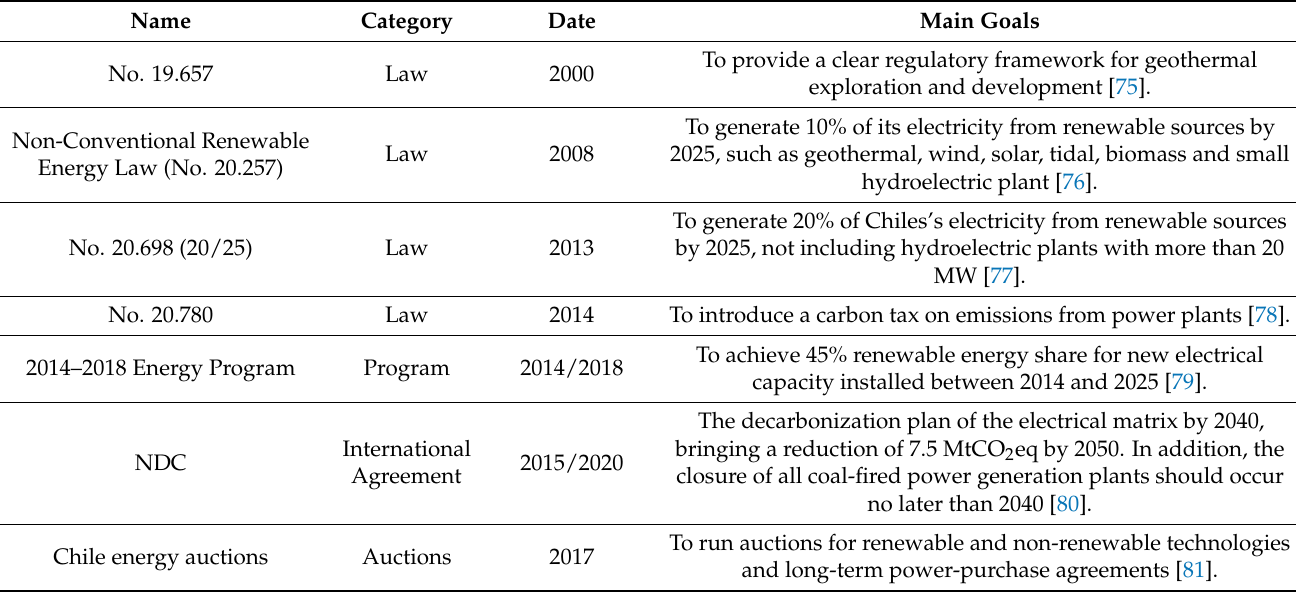
Table 4. Main government incentives for the entry of renewable energy into Chile’s electricity